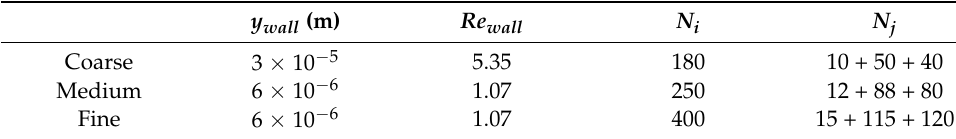
Table 3. Details of the three